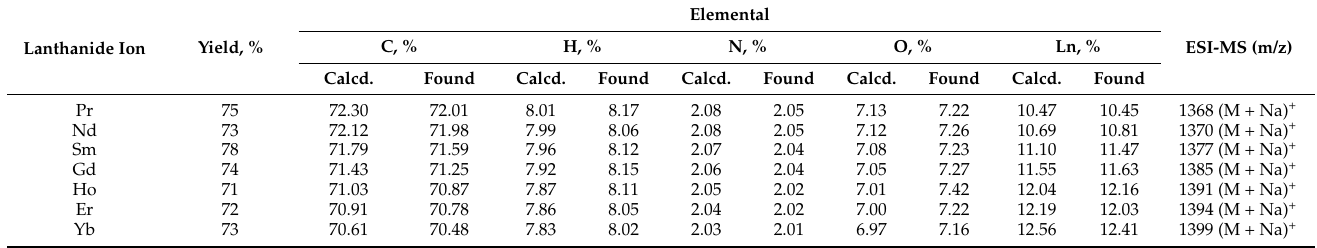
Table 2. The results of the analysis of synthesized Ln(III)